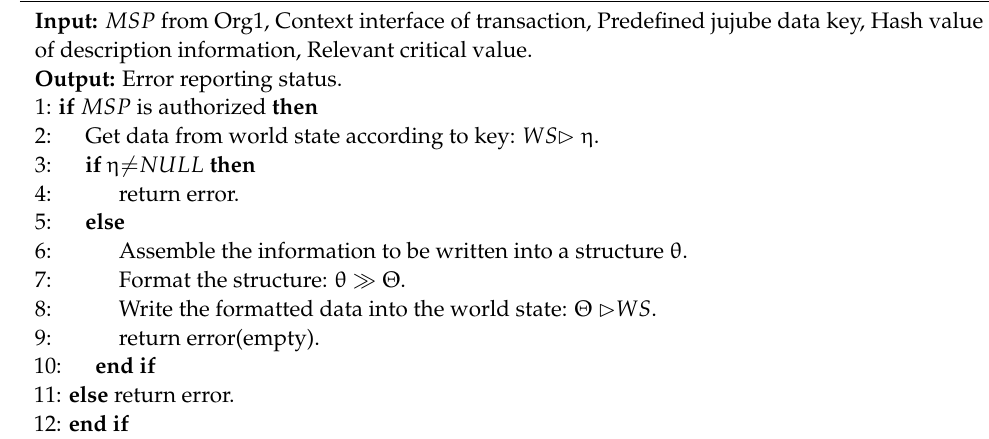
Algorithm 2 Process of Writing Jujube Data in the Common